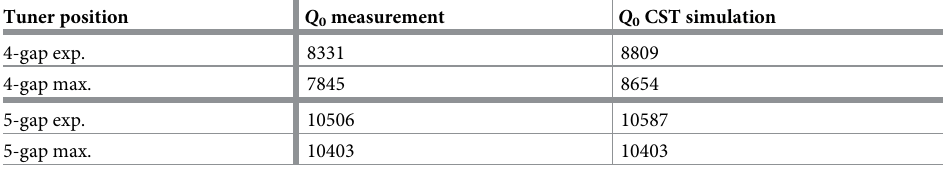
Table 2. Simulated and measured unloaded quality factor Q 0 for the expected (exp.) tuner position to reach f R and for the maximum (max.) extended tuning rod of both buncher